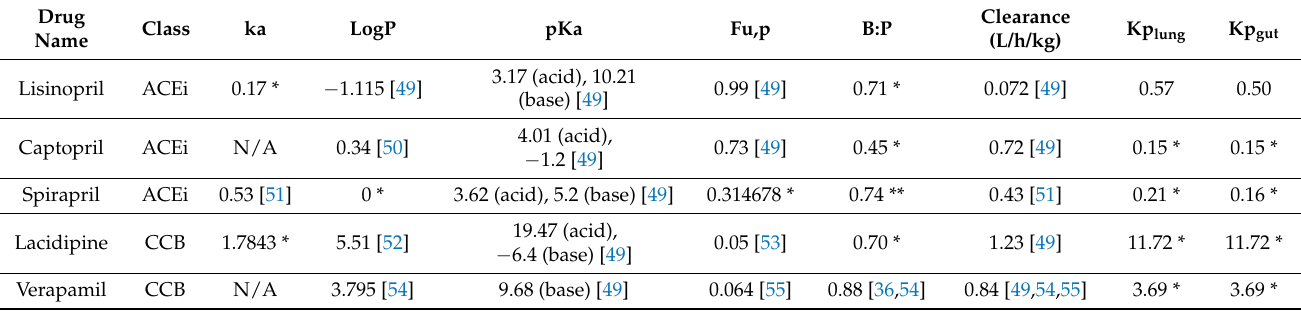
Table 2. Classification of identified ACEi, CCB compounds, and utilized physicochemical and pharmacokinetic (PK) parameters values obtained from literature, default value approximation, or machine learning (ML) optimization.